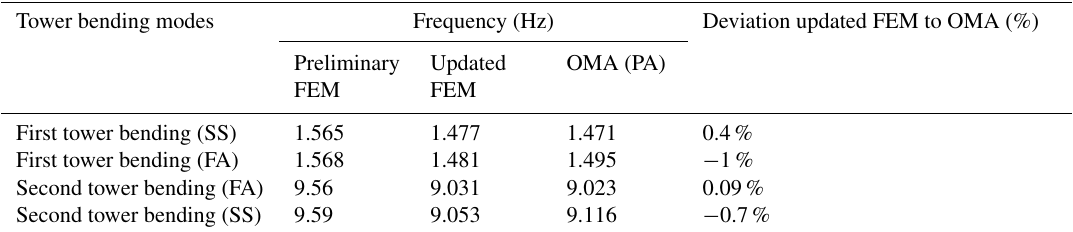
Table 5. Updated FE model vs. test